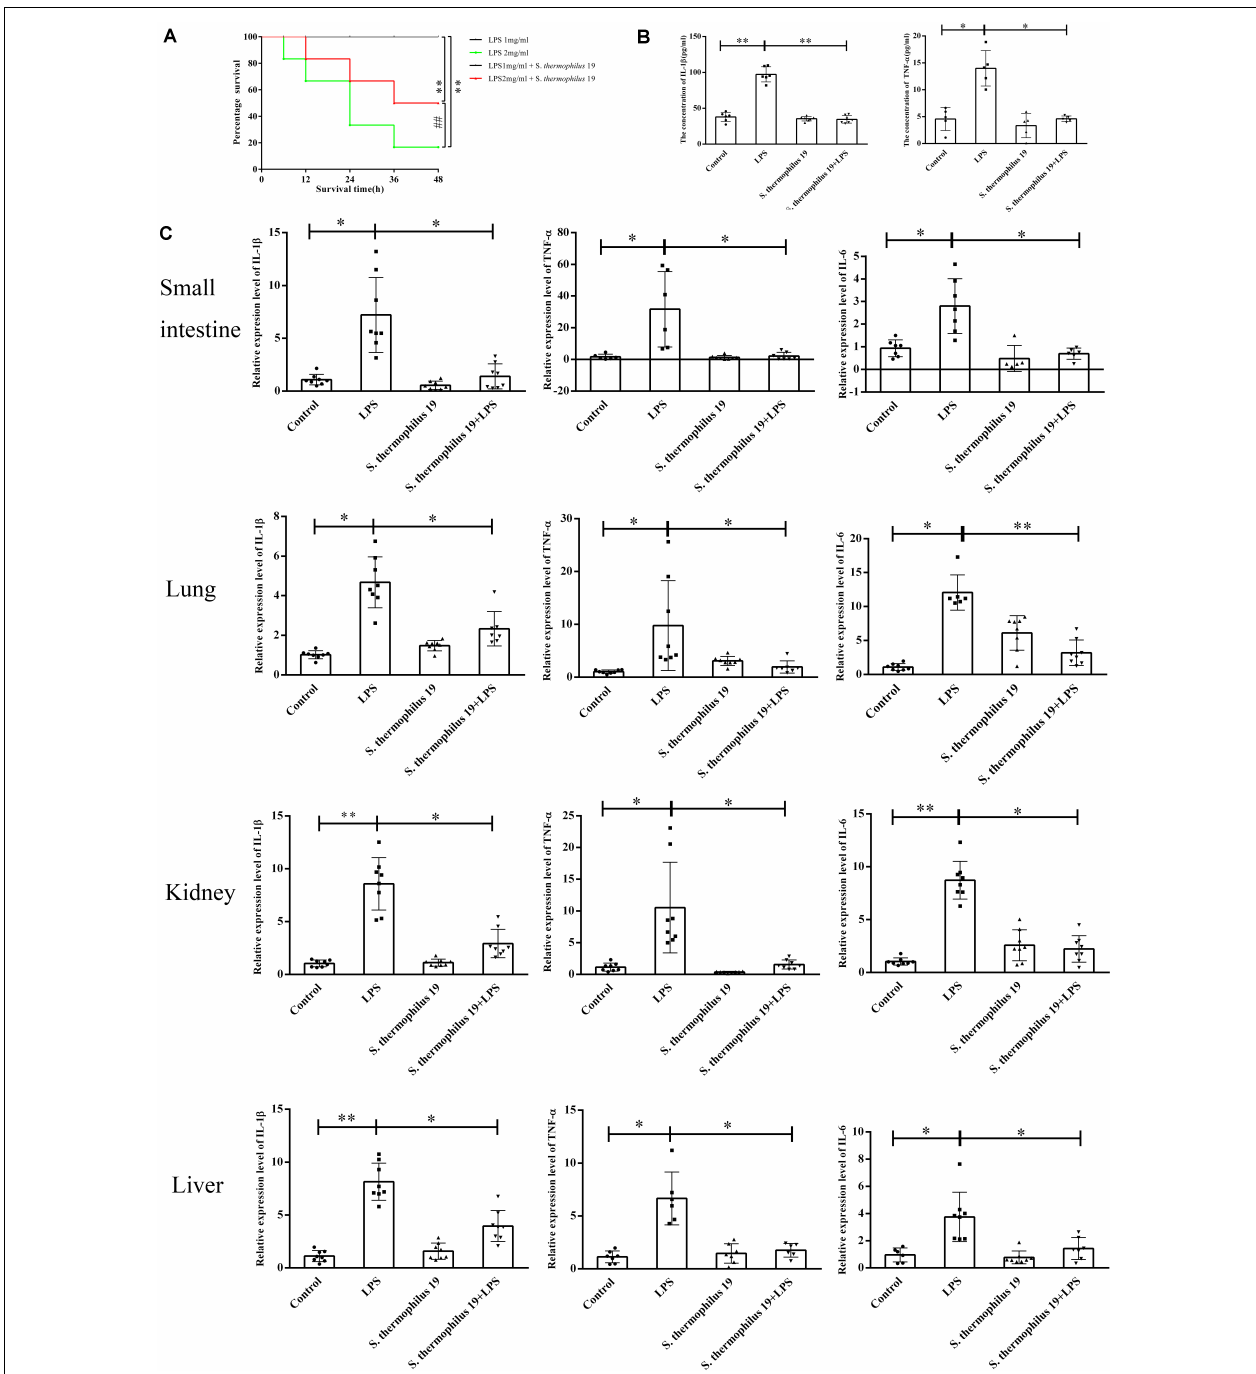
FIGURE 2 | S. thermophilus 19 alleviate the inflammatory reaction caused by LPS-induced sepsis. (A) Survival rates of mice with or without S. thermophilus 19 treatment after 48 h stimulation with different dose of LPS ( n = 10). (B) Levels of IL-1 β and TNF- α in blood were determined using commercial ELISA kits ( n = 8). (C) S. thermophilus 19 intervention resulted in decreased inflammation in the small intestine, lung, liver, and kidney ( n = 8). Error bars represents SEM. ∗ P < 0.05 and ∗∗ P < 0.01.